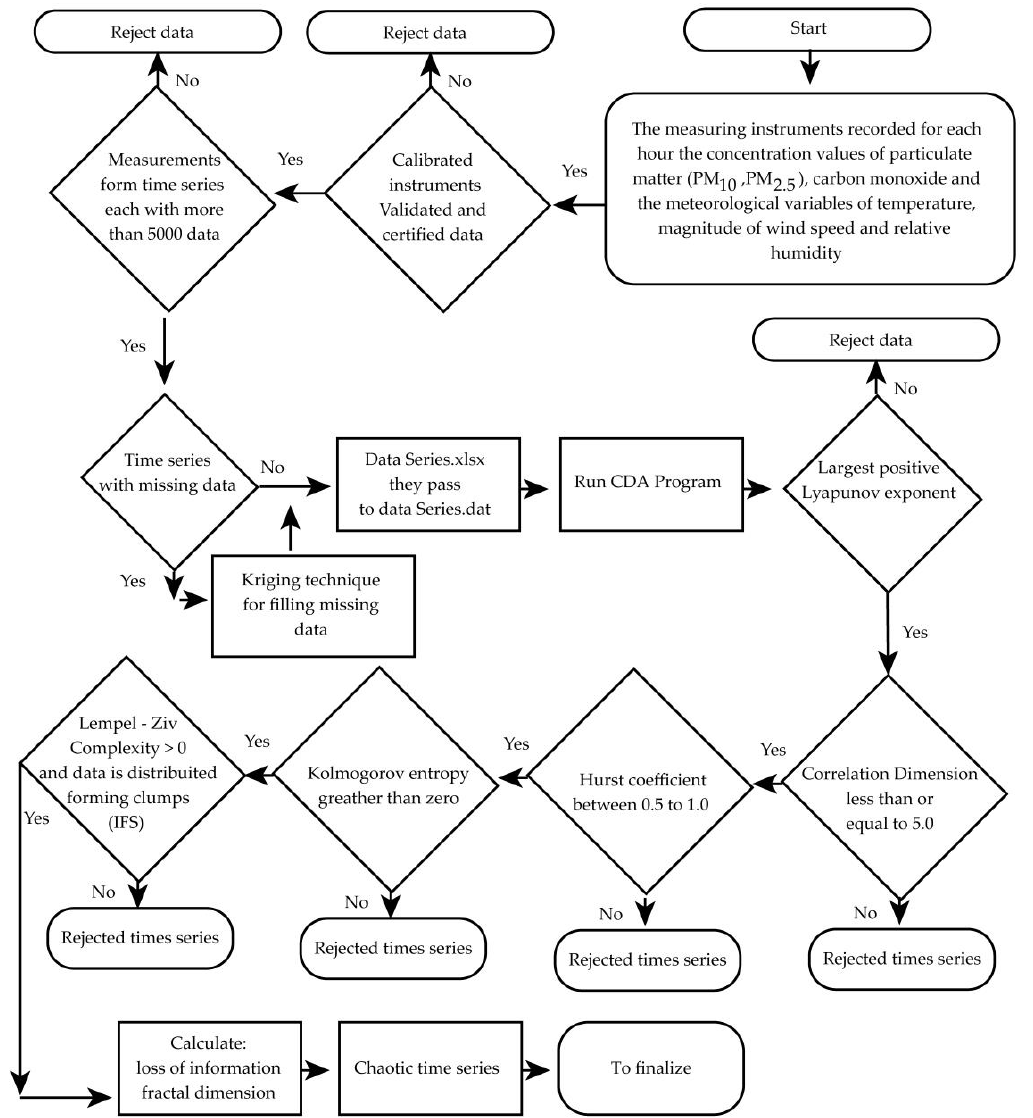
Figure 1. The described process is repeated for the six variables measured in each of the twelve locations, giving a total of 72 time series (each series contains 28,463